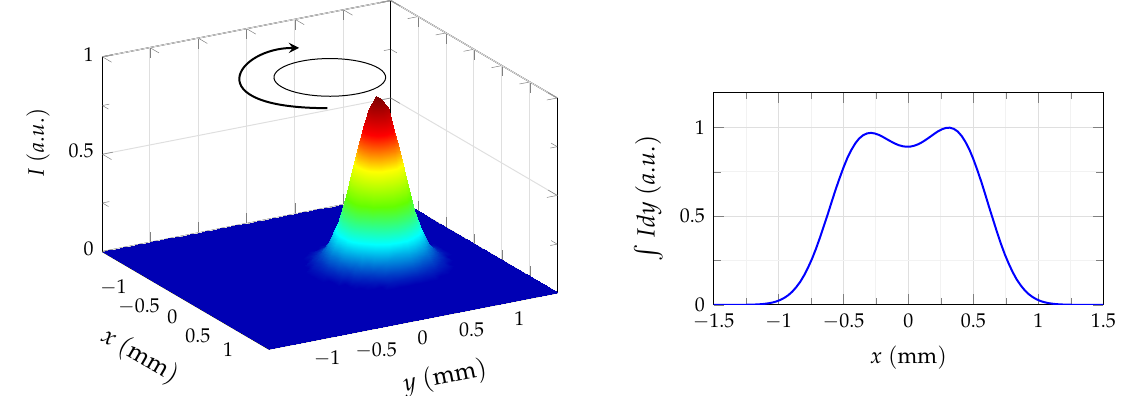
Figure 8. A two-dimentional Gaussian approximates the intensity emitted by the discharge channel. After integration on a detector, a bimodal intensity distribution can be observed when the movement of the channel is taken into account.